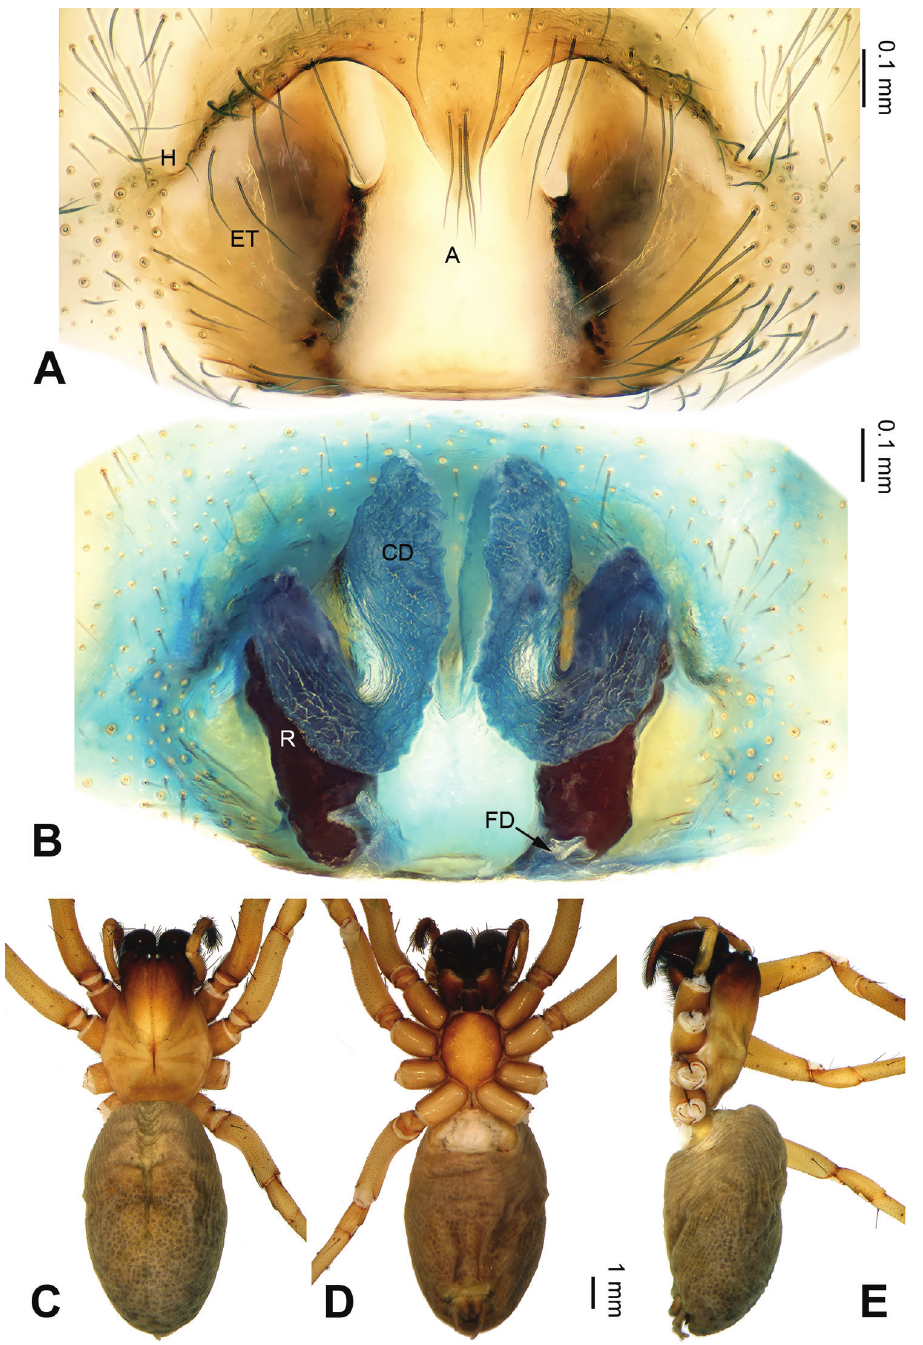
Figure 5. Pireneitega ramitensis sp. n., female holotype. A Epigyne, ventral B Vulva, dorsal C Habitus, dorsal D Habitus, ventral E Habitus, ventral. Scale bars equal for C, D, E